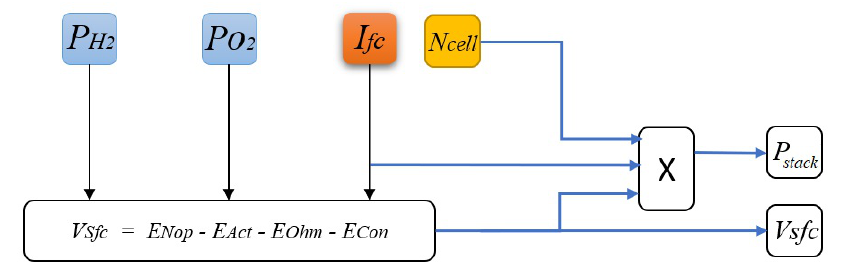
Figure 2. PEMFC static model.